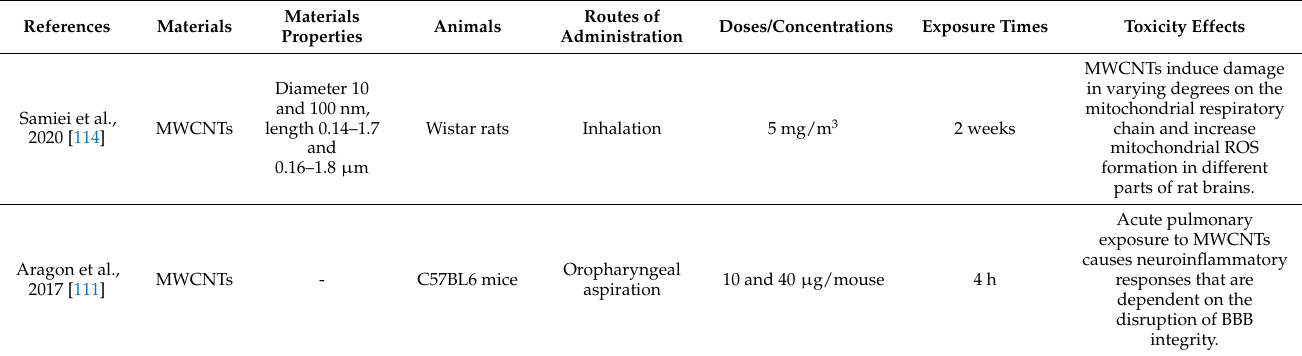
Table 6. Neurotoxicity of pristine carbon nanotubes using rodents as animal